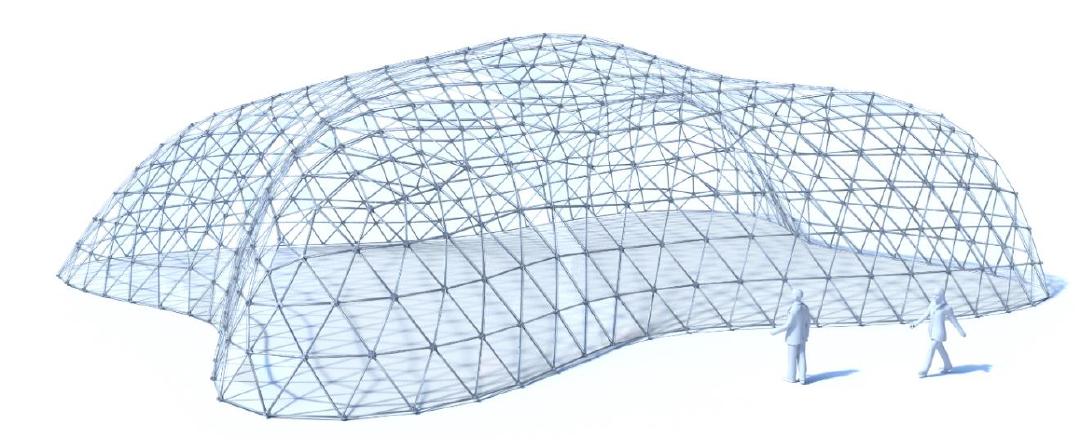
Fig. 1 Rendering view of a reinforced and post-tensioned glass shell (Simplilium case study). Each pair of adjacent panels shares an unbonded reinforcement, which is bolted onto spatial steel nodes that provide also for the panels’ clamping. Thus, all the reinforcements form a triangulated truss that can be regarded as redundancy barrier to avoid global collapses in case of glass cracking. Post-tensioned cables, which are point-fixed on the same nodes, prevent the glass from carrying tensile stresses and increase the global stiffness. The cables result slightly offset from the main layer of glass as shown in Fig. 2.